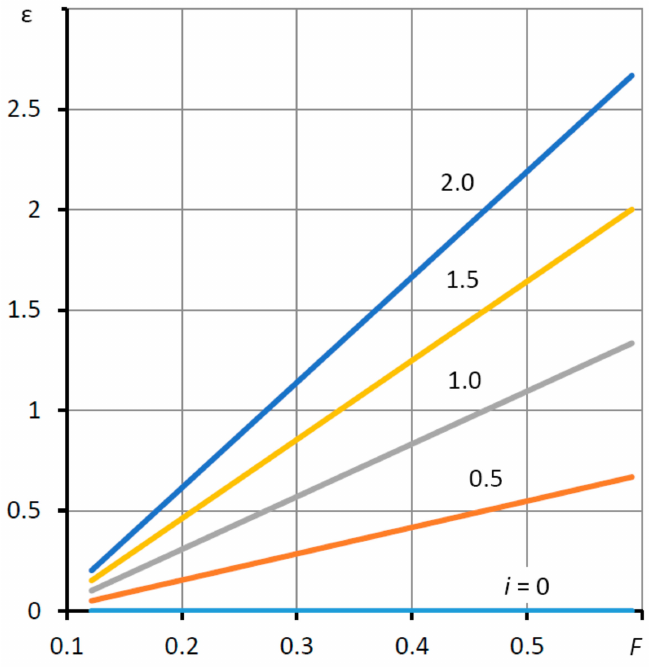
Figure 6. Characteristics of deformation ε ( F ) of elastic ring 4 at different values of the elasticity coefficient K e = i K e 0